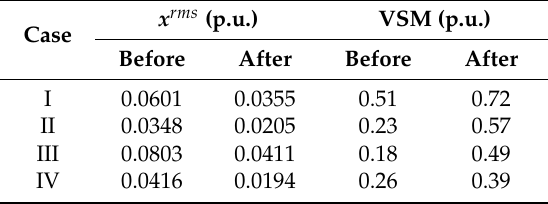
Table 2. Performance evaluation for the proposed scheme on the IEEE 30-bus system. x rms (p.u.) Case Before After